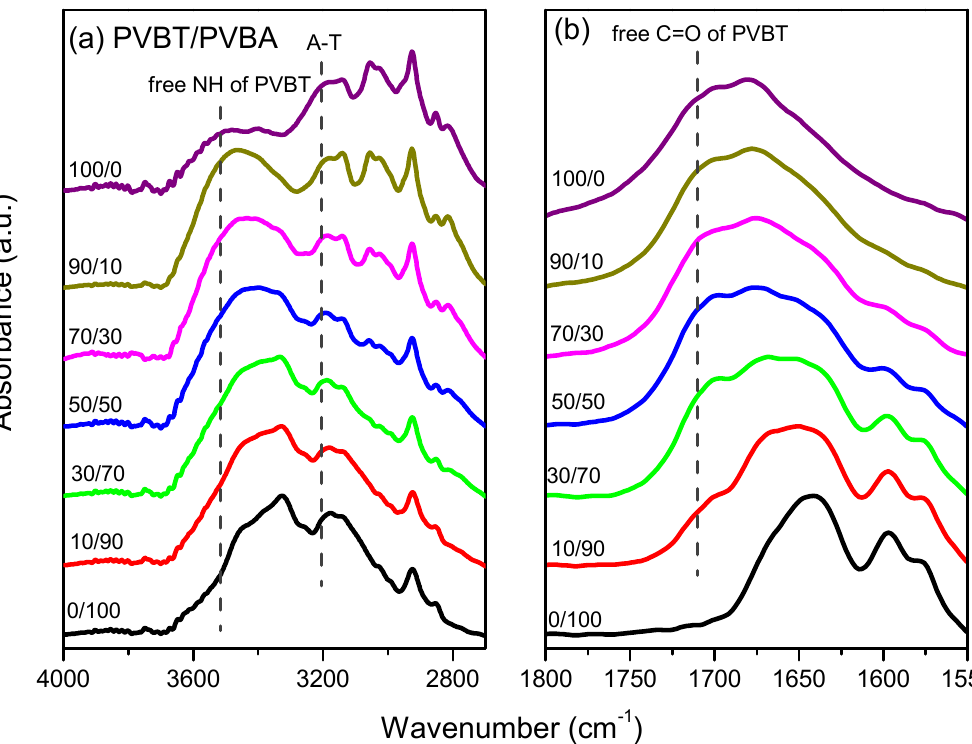
Figure 8. FTIR spectra of various PVBT/PVBA blend complexes in the regions ( a ) 4000–2700 cm − 1 and ( b ) 1800–1550 cm − 1